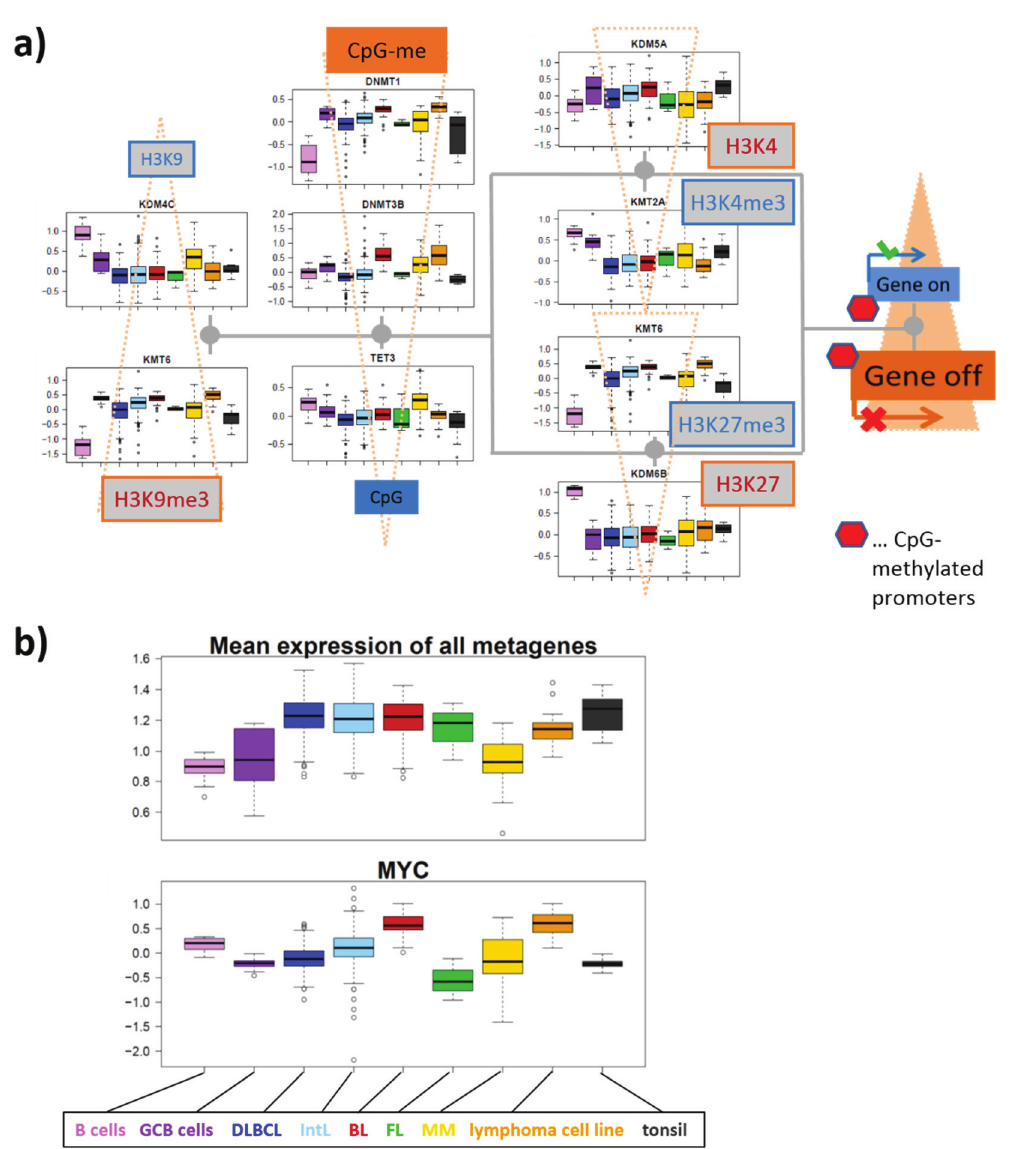
Figure 10. ( a ) The expression profiles of the methyltransferases and demethylases of H3K9, H3K4, H3K27 and of DNA-CpG’s suggest a shift of expression of the affected genes towards repressed and CpG-methylated promoter states. The scheme is redrawn from Figure 4 and supplemented by selected expression profiles of the respective enzymes determined from the lymphoma cohort studied. The triangles indicate the shift of the methylation-demethylation reactions in lymphoma compared with B cells deduced from the expression profiles from the respective enzymes. ( b ) Expression profiles of MYC and of the mean total expression averaged over all SOM-metagenes of each samples. Total expression is consistently activated in lymphoma except MM compared with B and GCB cells, whereas MYC is on high level in BL and IntL carrying genetic activating MYC